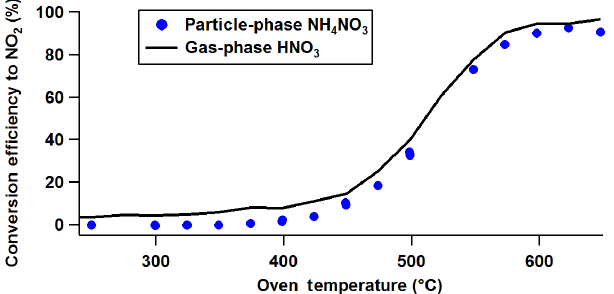
Figure 7. Measured thermogram of NH 4 NO 3 particles as solid cir- cles from the NOAA TD-CRDS. The black solid line indicates the measured thermogram of gas-phase HNO 3 at a 1.9slpm flow rate (from the gold squares trace in Fig. 2). The close match of these two thermograms indicates that the NH 4 NO 3 particles go through HNO 3 as an intermediate and is a good indication that complete conversion is